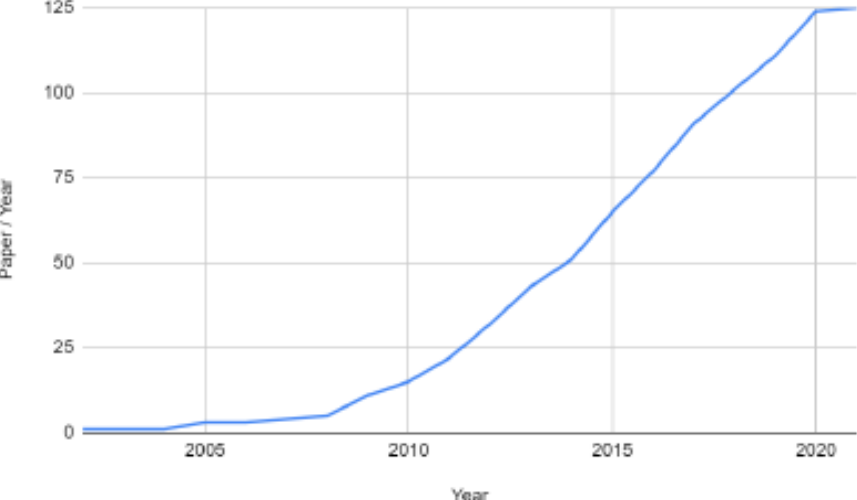
Figure 1. Counting evolution of the papers that mention or treat RL processes or activities in the literature.